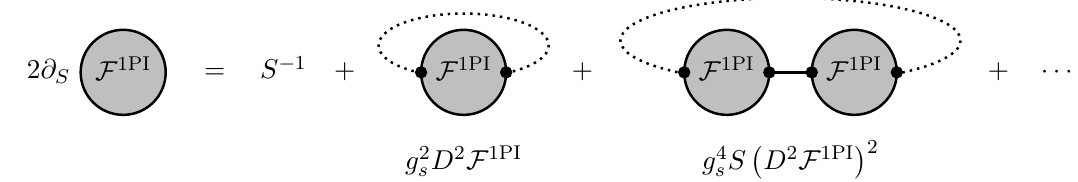
Figure 5 . Diagrammatic interpretation of the holomorphic anomaly equation (3.16). The propa- gator removed by the action of ∂ S is indicated by the dotted